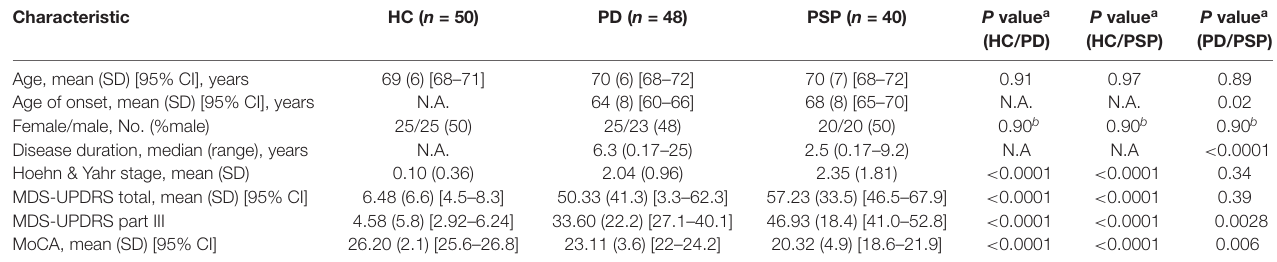
TABLE 1 | Demographic and clinical characteristics of Parkinson’s disease Biomarkers Program (PDBP) participants.